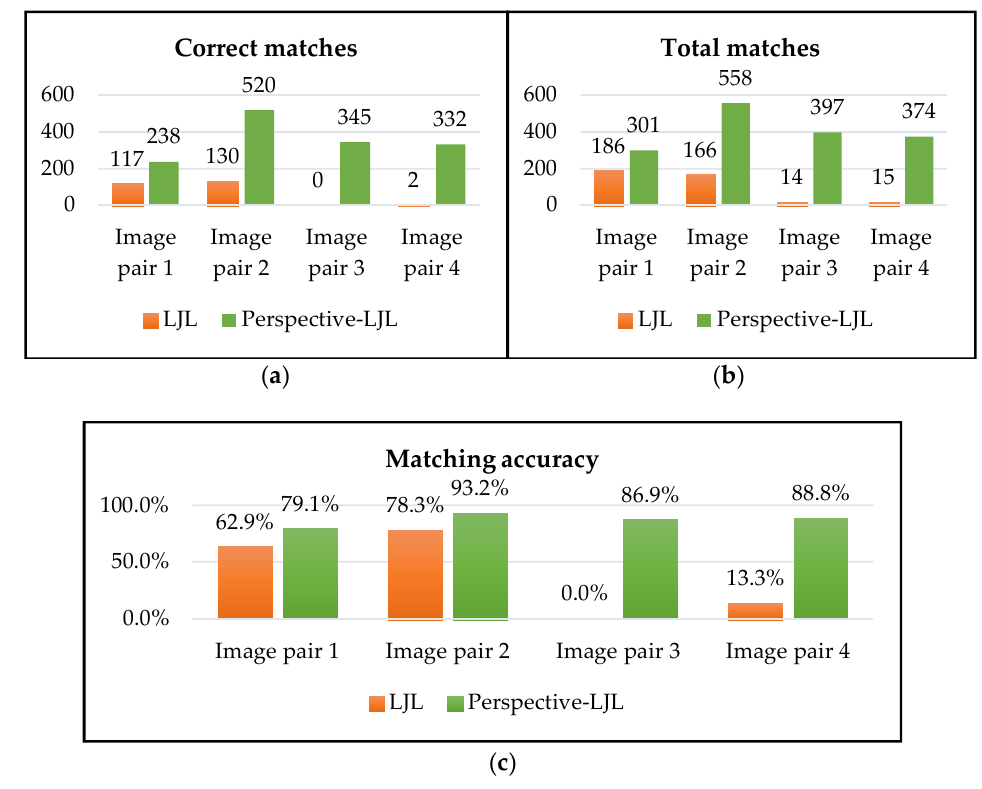
Figure 15. Comparison of the correct number, the total number, and the accuracy rate of the matched